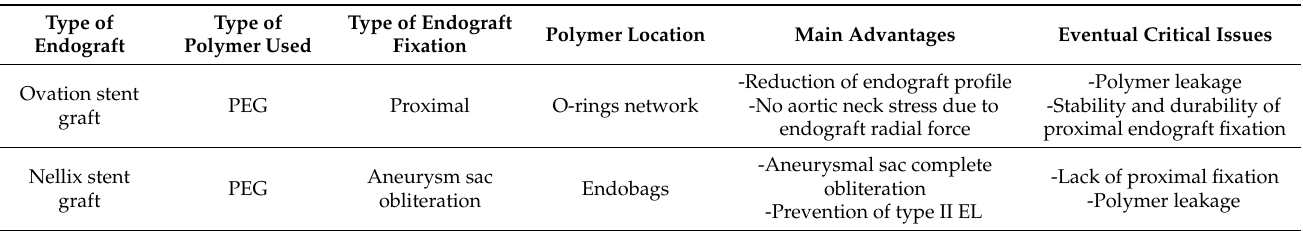
Table 1. Main characteristics of the two polymer-based platforms used in the Endovascular Aneurysm Repair Procedures. Type of